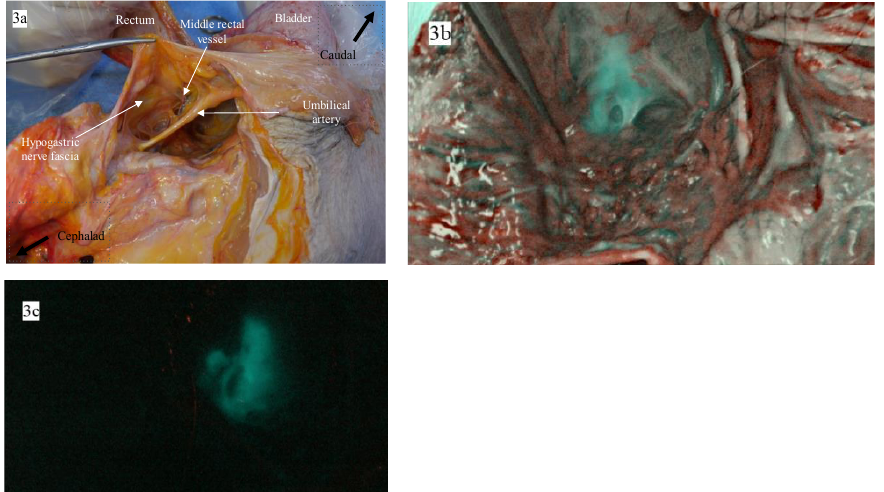
Figure 2. The macroanatomical examination of the lymphatic drainage from the distal rectum in fluorescence signal. Figure 4 demonstrates the different patterns of the ICG fluorescence fresh cadavers. ( a , d , g ) Multiple perforating small lymphovascular branches connect the mesorec- tum to the presacral fascia; ( b , e , h ) the color image overlaid with ICG fluorescence; ( c , f , i ) the pure signals observed intraoperatively. ICG fluorescence image under NIR light.